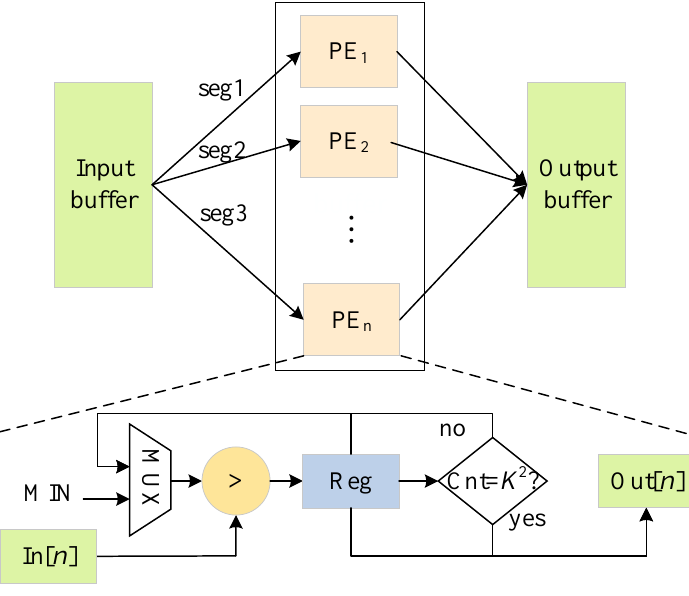
Figure 15. Architecture of the max-pooling module.